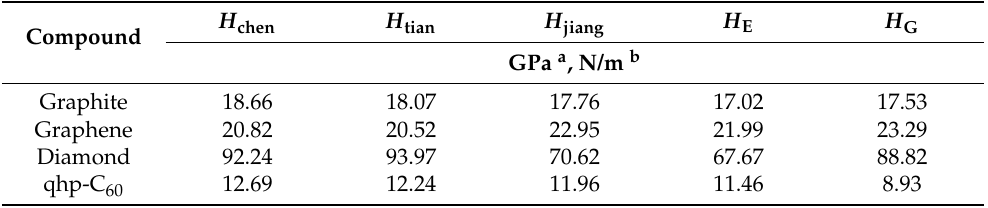
Table 3. The hardness of the four carbon materials.